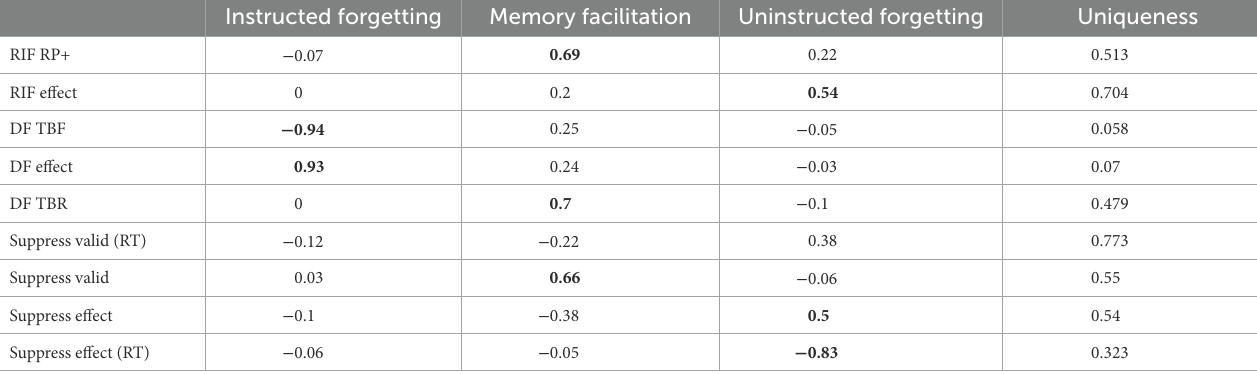
TABLE 3 Variable loadings on the principal components after applying a direct oblique rotation (Oblimin).